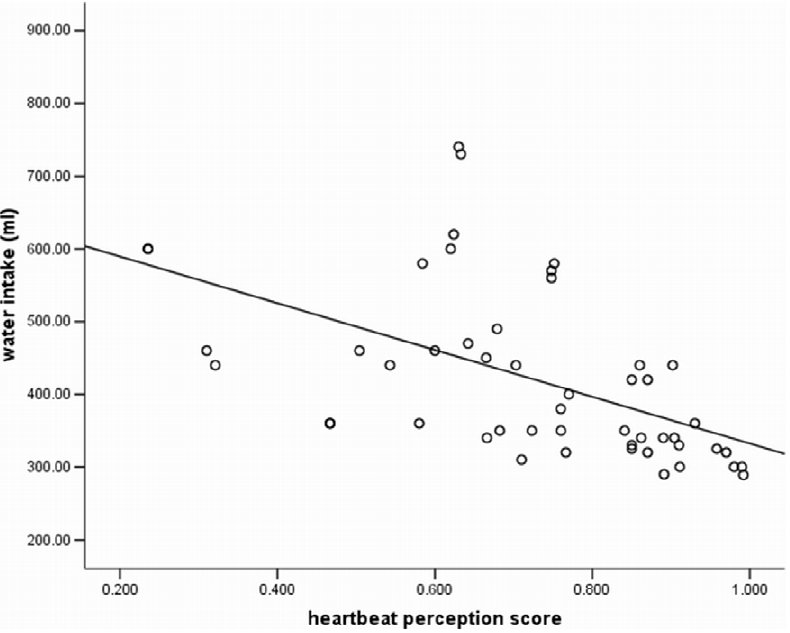
Figure 2. Correlation plot between heartbeat perception score and ingested water volume (ml) (r= 2 .50, p=.001).